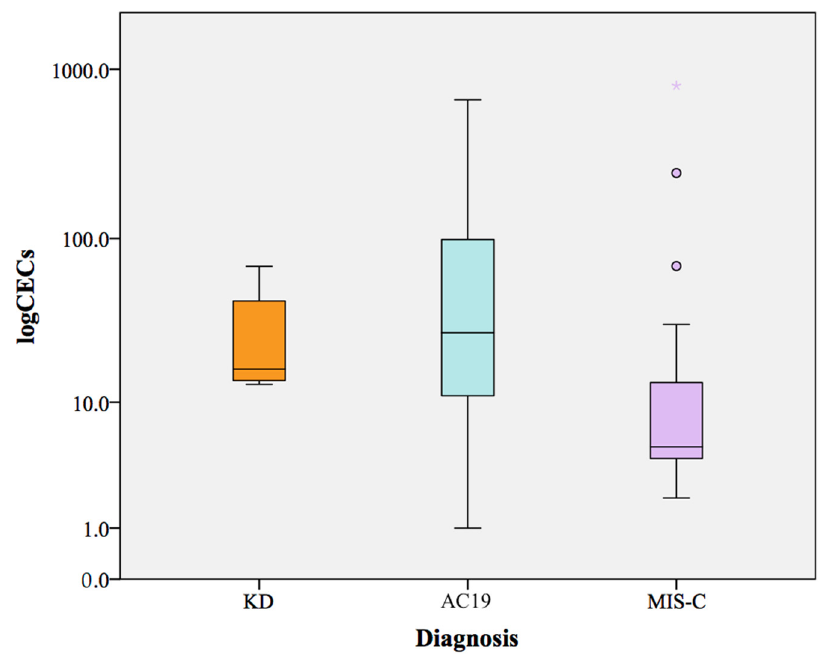
Figure 1. Boxplot of CEC levels in KD, AC19 and MIS ‐ C patients during the acute stage of diseases. KD stands for Kawasaki Disease; MIS-C stands for Multisystem Inflammatory Syndrome in Children; KD stands for Kawasaki Disease; MIS ‐ C stands for Multisystem Inflammatory Syndrome in Children; AC19 stands for acute COVID ‐ 19. AC19 stands for acute